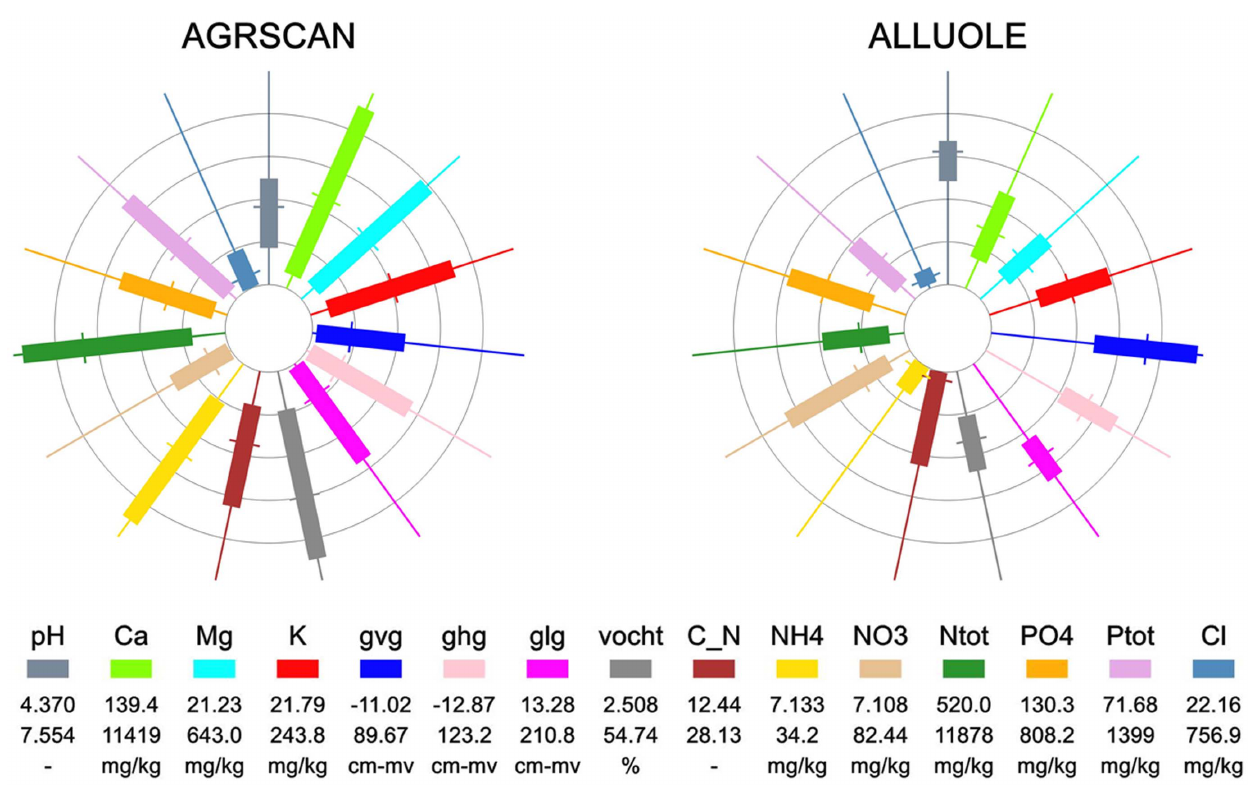
Figure 2. Abiotic ranges for Agrostiscanina (brown bent, left) and Alliumoleraceum (field garlic, right). The bar gives the range based on the 5 and 95 percentile of the occurrence of the species. Each spoke of the wheel represents a different abiotic parameter. The values per parameter are standardised with the minimum absolute value set to 0% and the maximum value set at 100%.The circles indicate the 0, 20th, 40th, 60th and 80th percentile. The wheels make it possible to compare the ranges between the species. With: pH: pH in water extract, Ca: calcium in water extract, Mg: magnesium in water extract, K: potassium in water extract, gvg: spring groundwater level, ghg: highest groundwater level, glg: lowest groundwater level, vocht: moist content of the soil, C_N: C/N ratio, NH4: ammonium content in CaCl2 extract, NO3: nitrate content in CaCl2 extract, Ntot: total nitrogen content, PO4: phosphate content, Ptot: total phosphor content and Cl: chloride content.